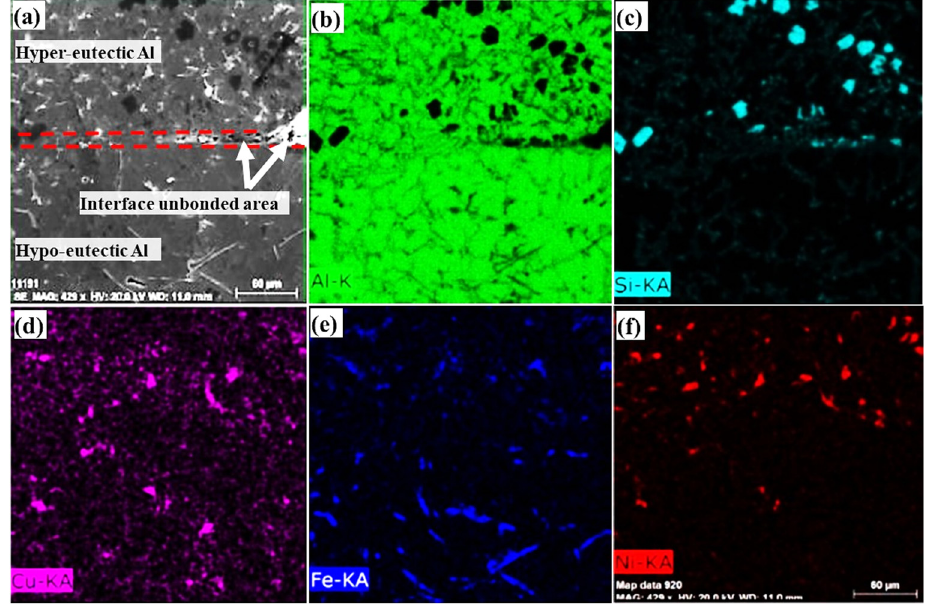
Figure 6. ( a ) SEM micrograph and concentration mappings of ( b ) Al, ( c ) Si, ( d ) Cu, ( e ) Fe, and ( f ) Ni for the Al/Al bimetal casting in the metallic mould using a 20 s time interval.